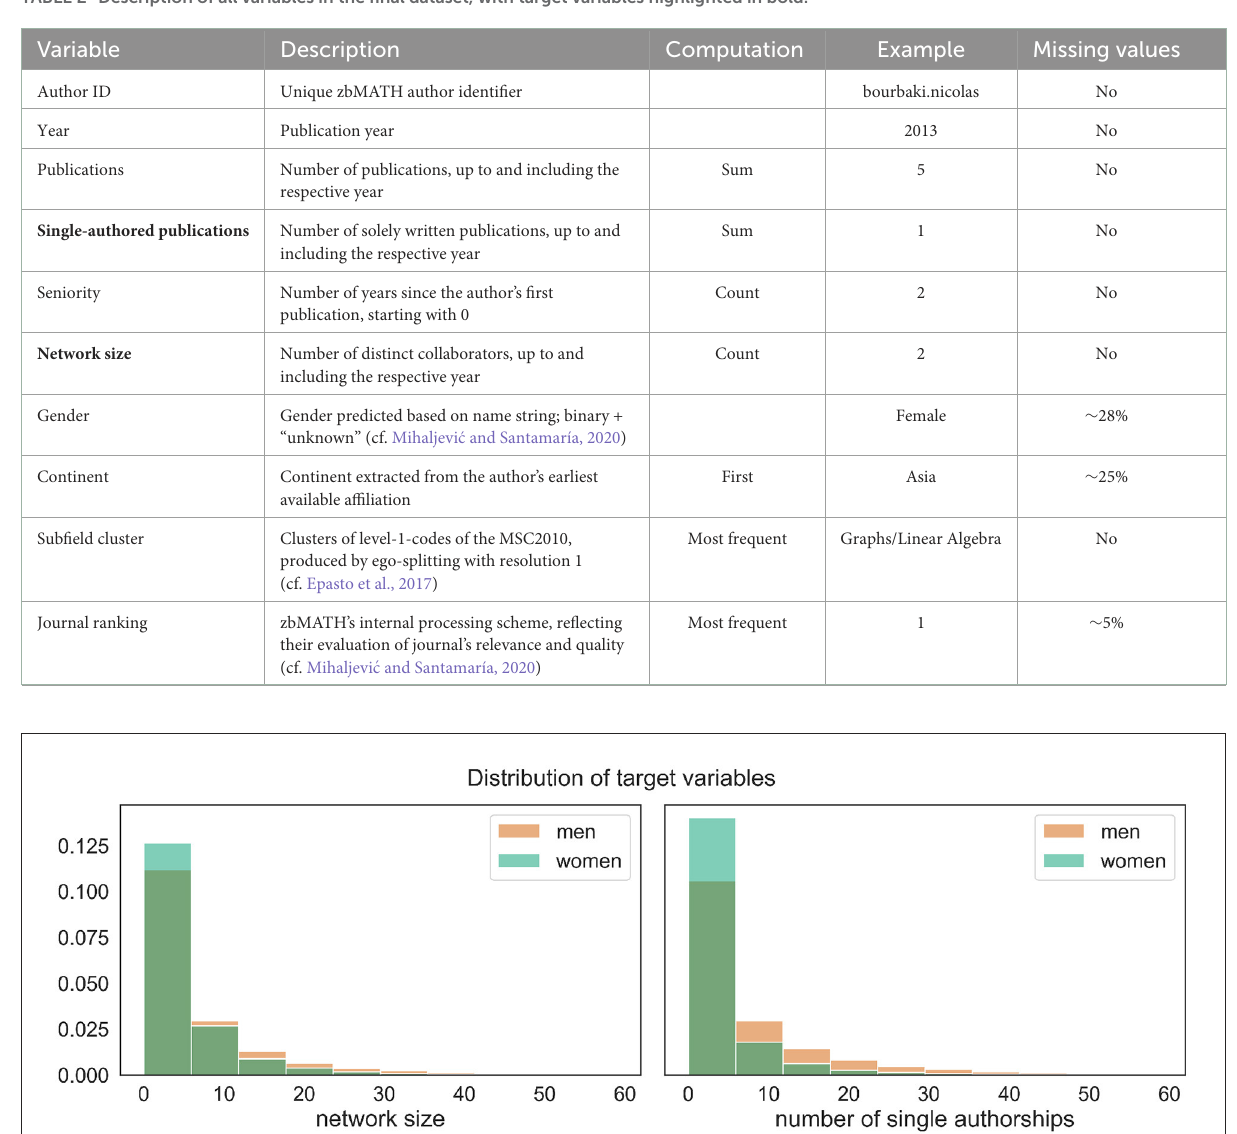
FIGURE4 Empirical distributions of the target variables broken down by gender, showing that, without taking any other variables into account, the proportion of women among authors with smaller networks and those writing less papers alone is higher compared to